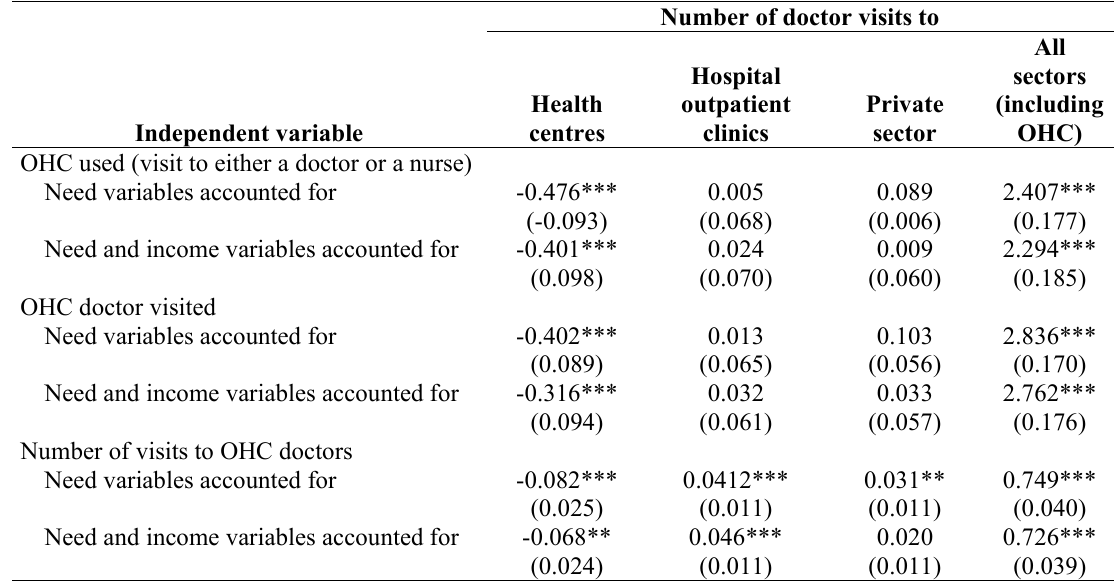
Number of doctor visits to Hospital Health outpatient centres clinics